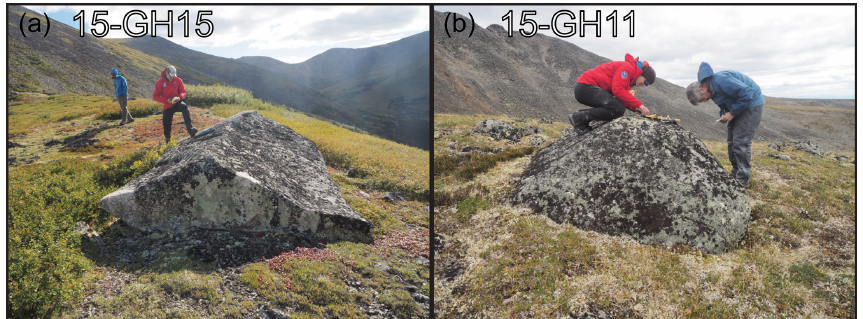
Figure 3. Example of boulders sampled from outer moraines (15-GH15; a ) and inner moraines (15-GH11; b ). Note in panel (a) the embedded character of the far side of the large erratic.